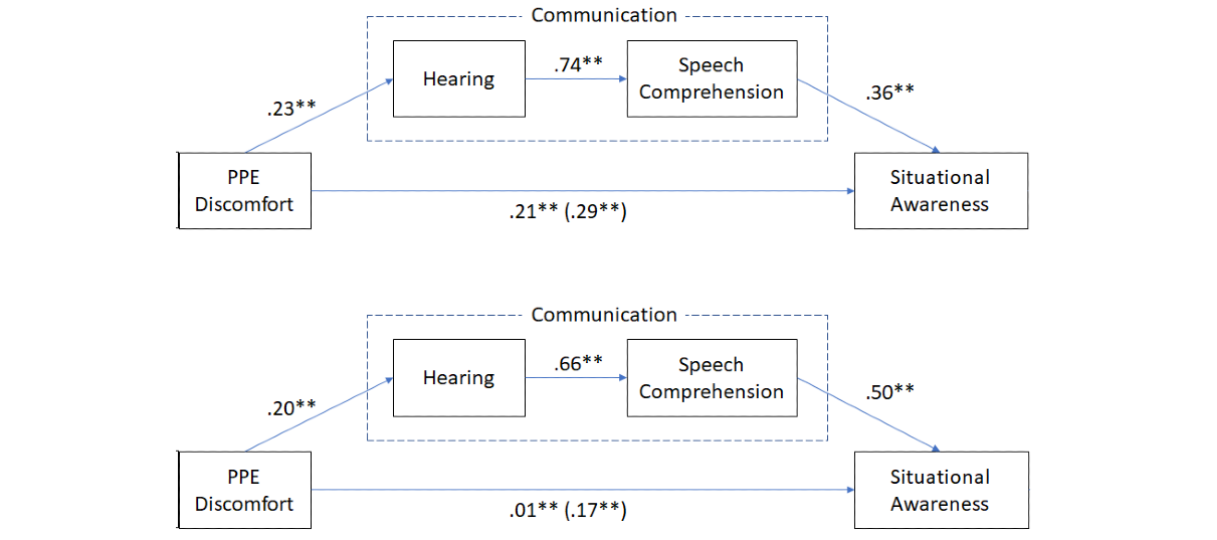
Figure 2. Mediation models of the responses in Israel (top model) and Portugal (bottom model). Each link is associated with its corresponding standardized coefficient, together with the significance indication (** indicates a significance level of P <.01). The direct link between PPE discomfort and situational awareness shows the total effect, including the presence of the mediating variables; the direct effect without the mediating factors is in parenthesis. PPE: personal protective